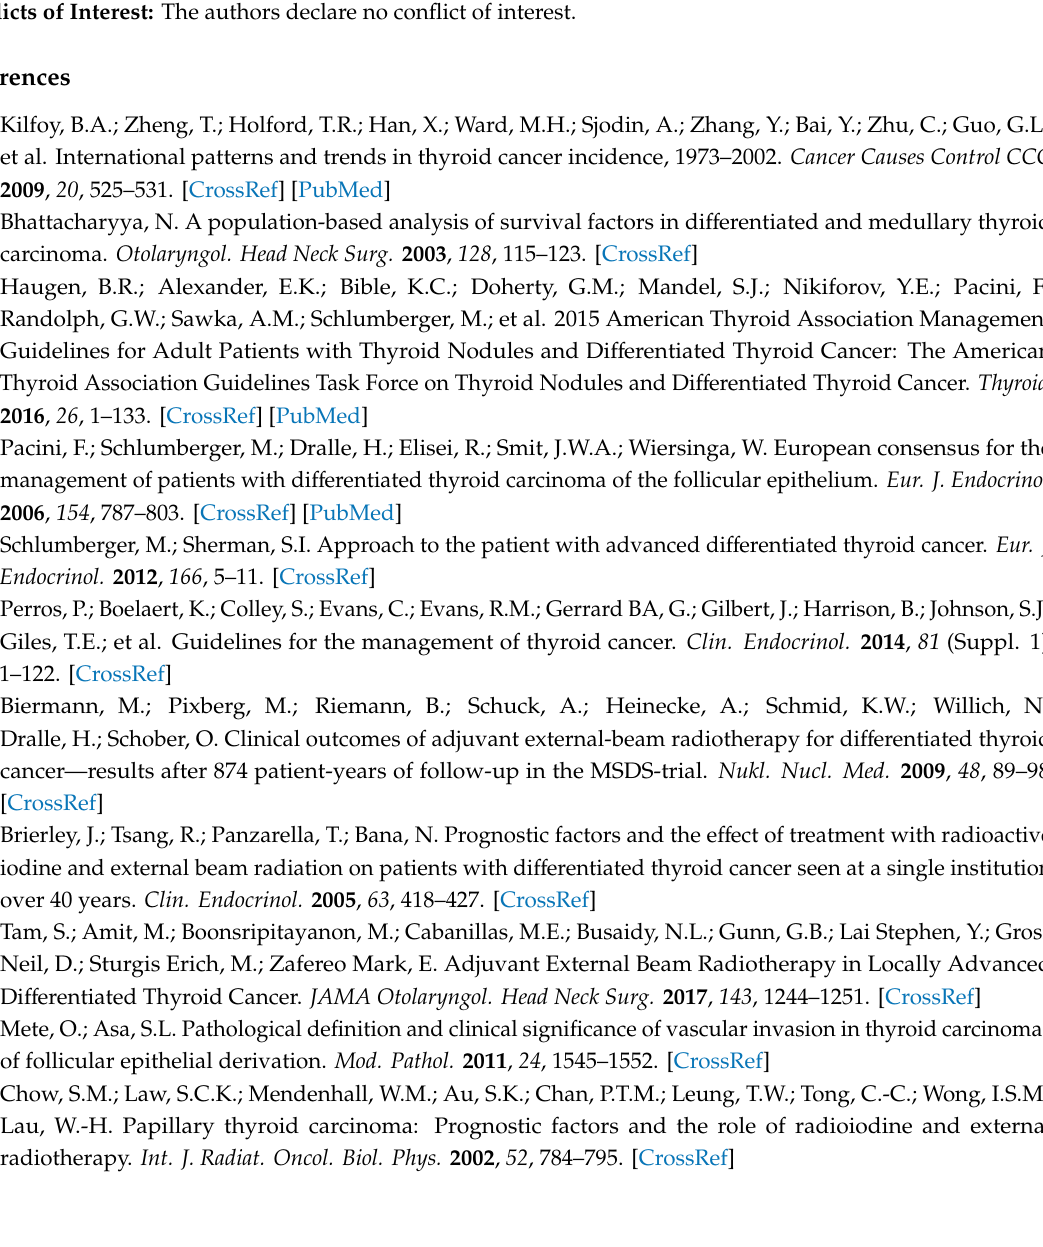
Table S1: Description of the number of missing data in the 254 analyzed patients; Table S2: Prognostic factors of locoregional recurrence without multiple imputations in the EBRT group: complete-case analysis; Table S3: Prognostic factors of overall survival without multiple imputations in the EBRT group: complete-case